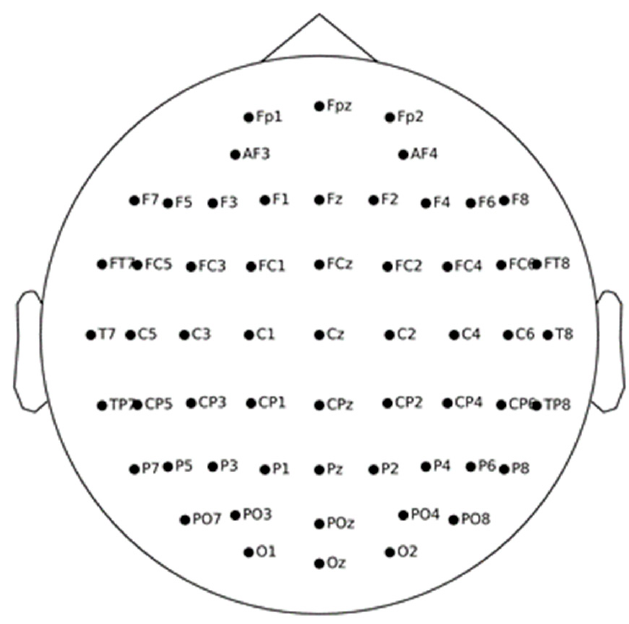
Figure 2. The EEG topo map of the 58 channels.